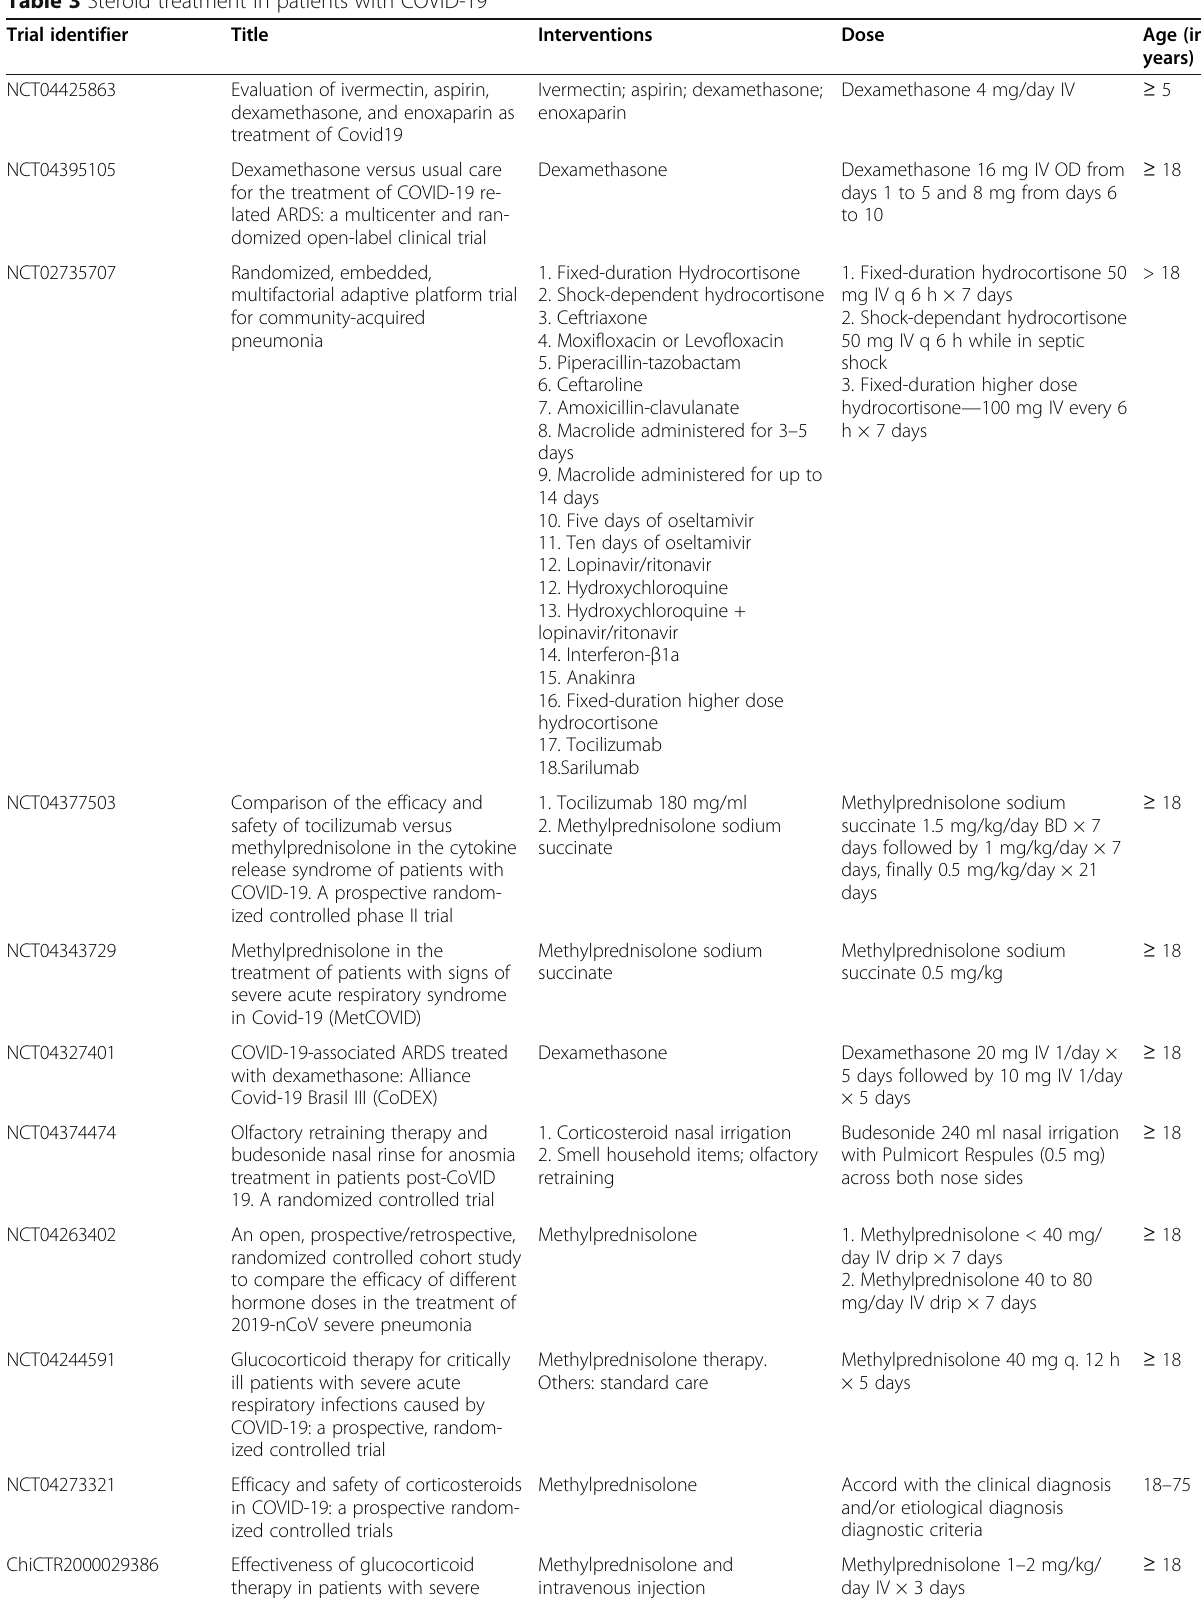
Table 3 Steroid treatment in patients with COVID-19 Trial